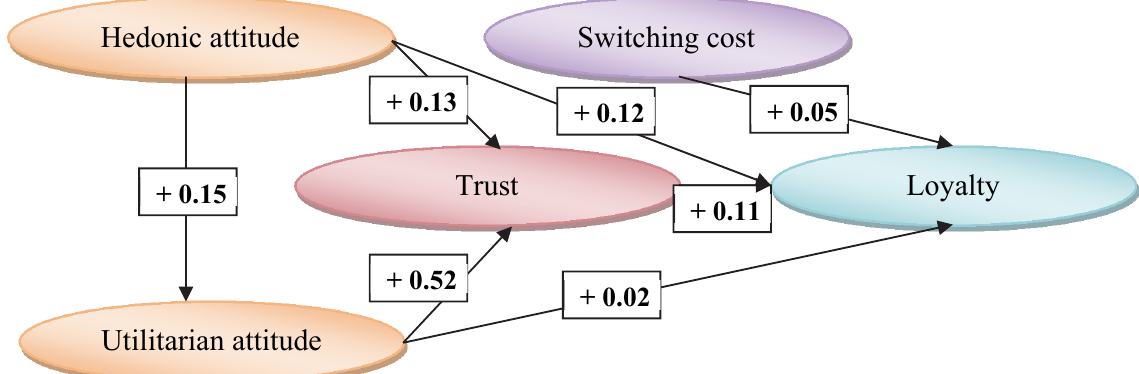
Fig. 3. Results of the structural model analysis show effects of attitude, trust, switching cost to loyalty at commercial banks in Ho Chi Minh city